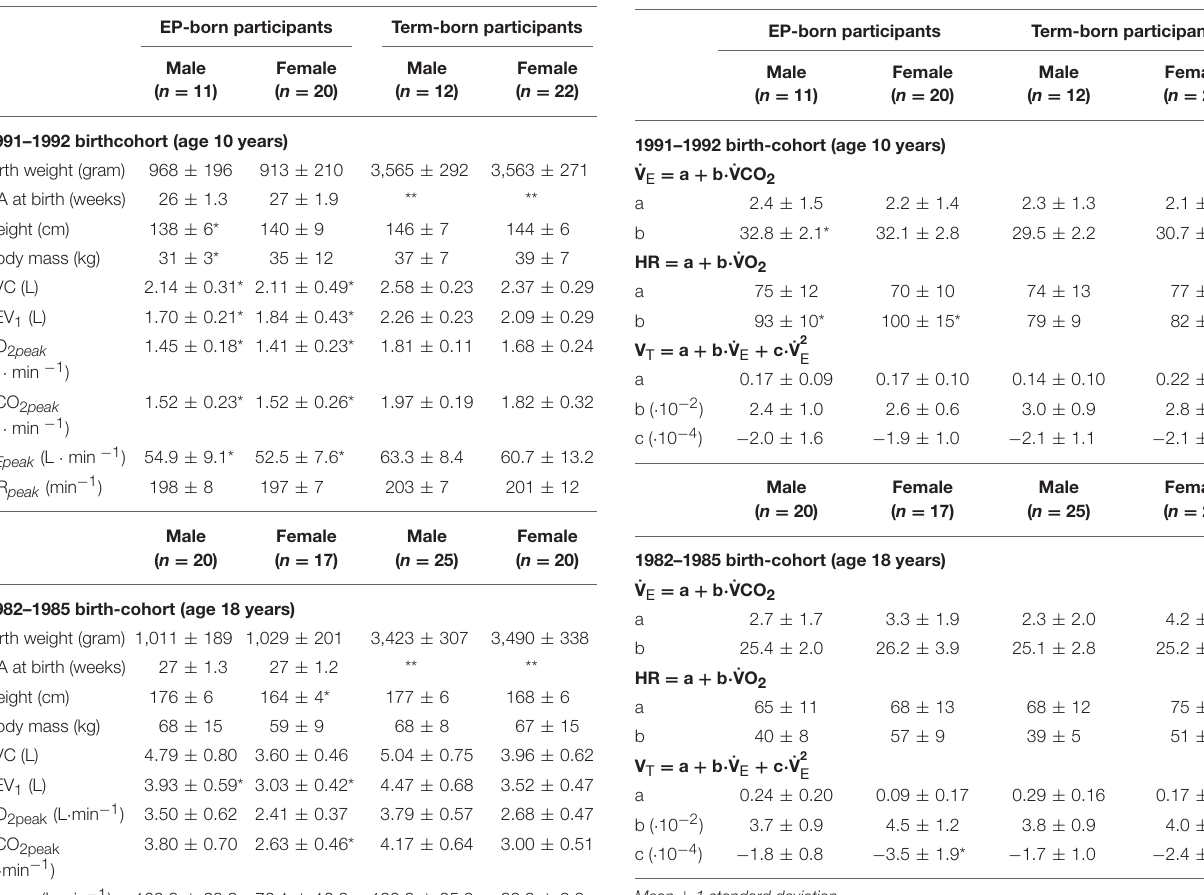
TABLE 2 | Curve parameters (a, b, and c) describing the relationships between ˙V E and ˙VCO 2 , between HR and ˙VO 2 and between V T and ˙V E